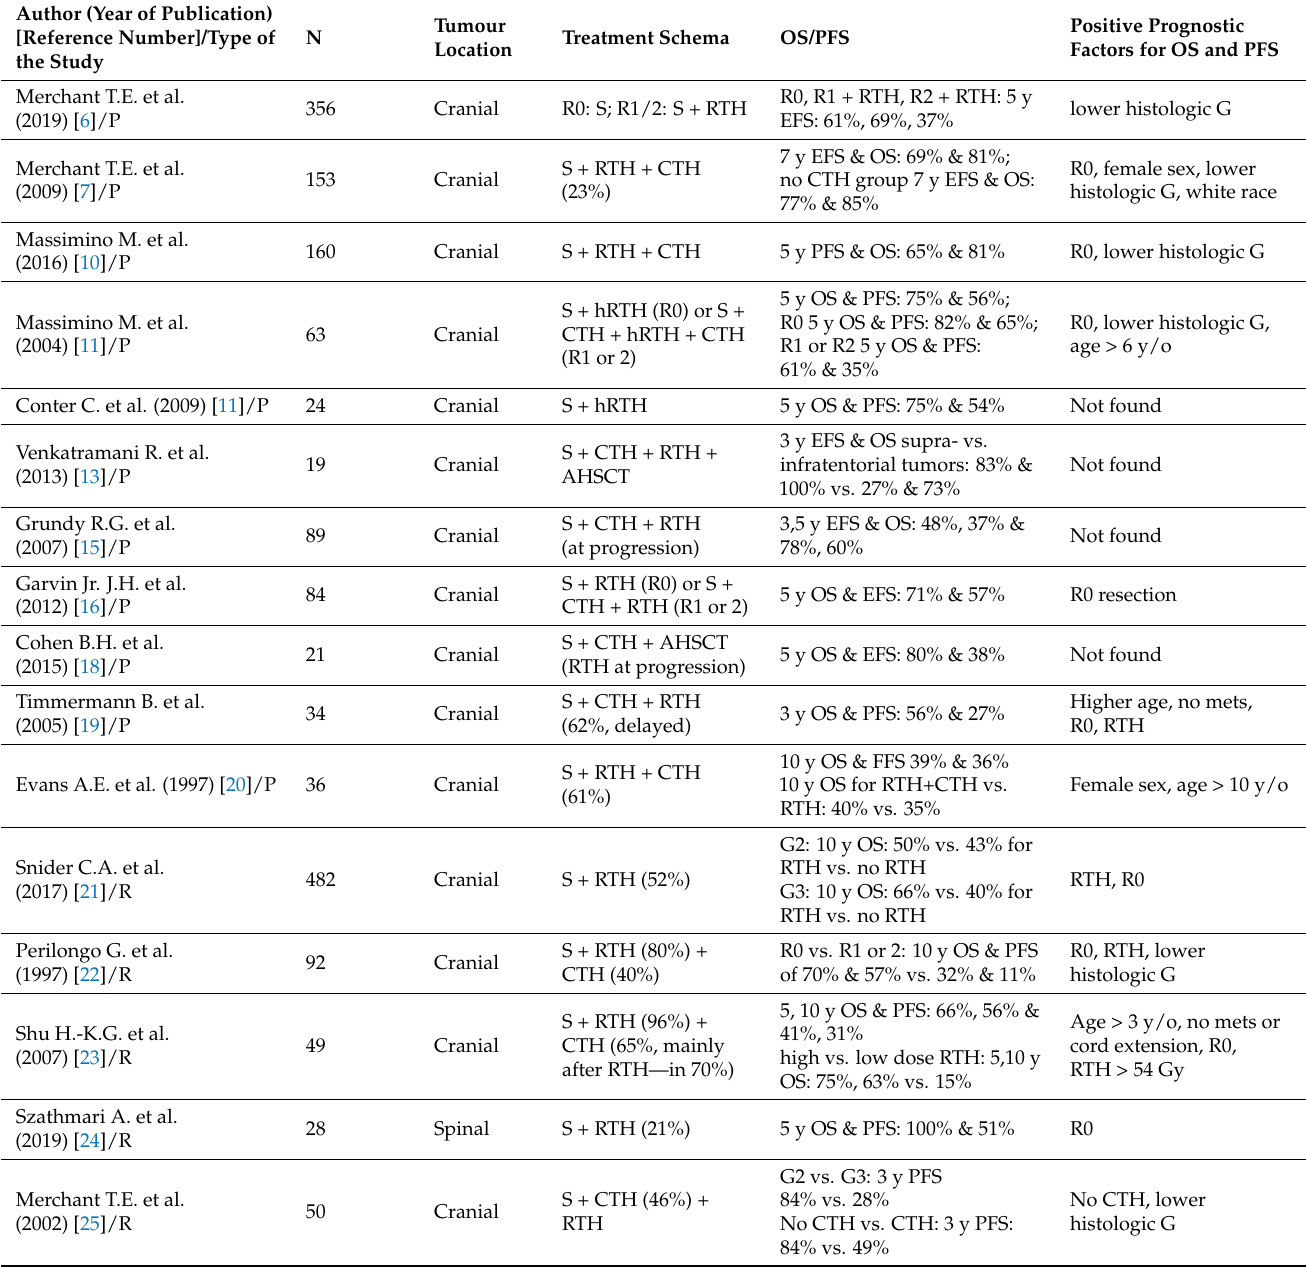
Table A1. Paediatric ependymomas—prognostic